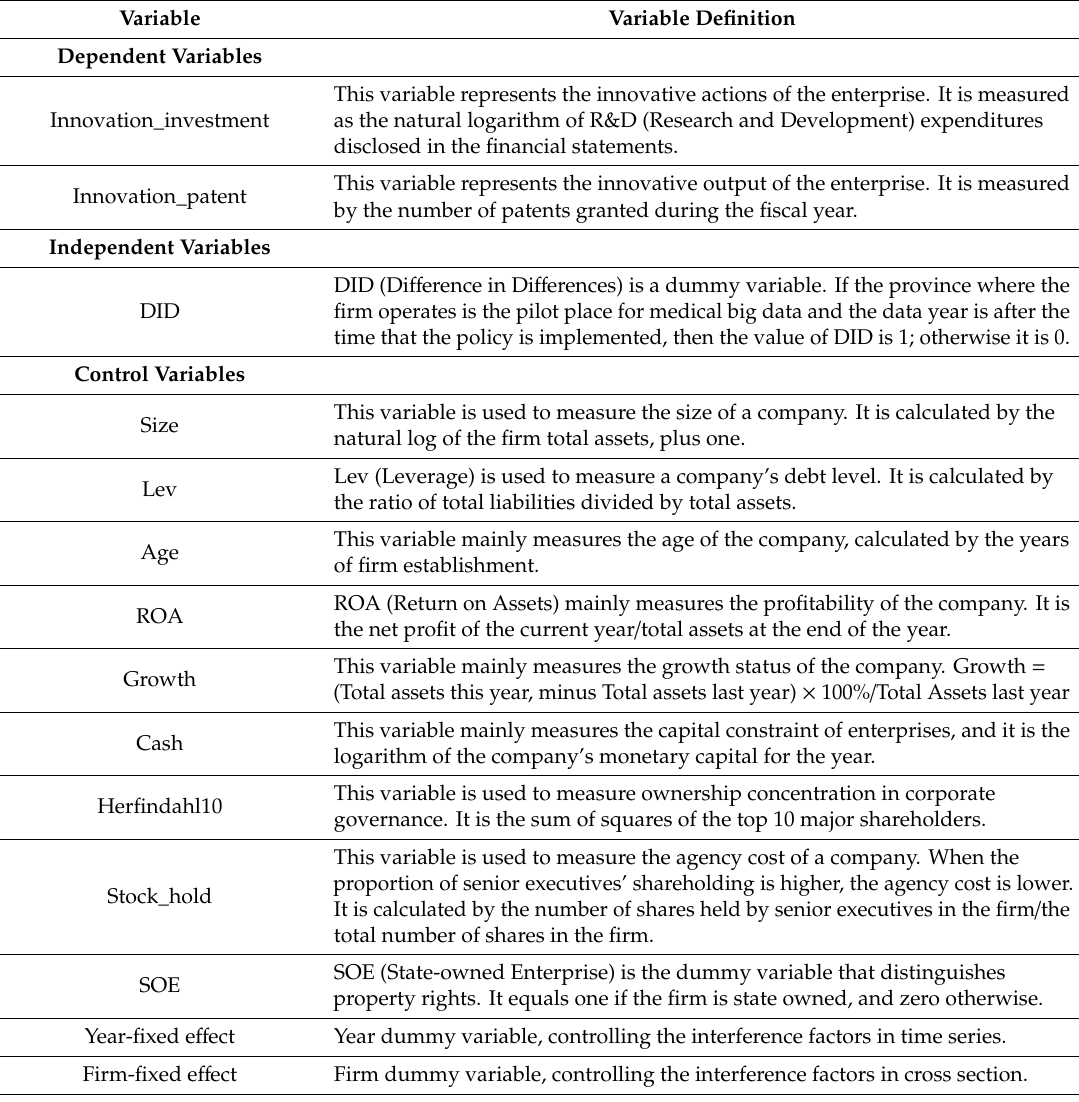
Table 1. Variable